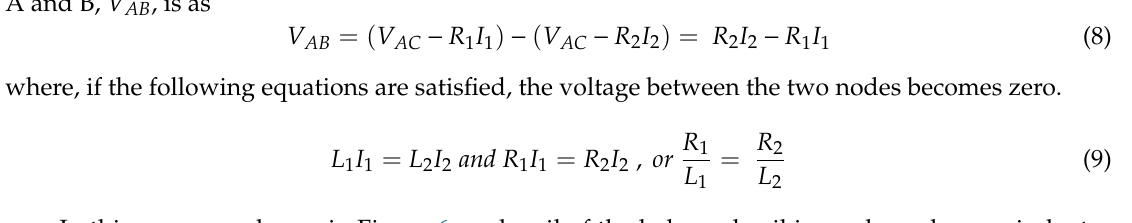
Figure 5. Maxwell bridge circuits.